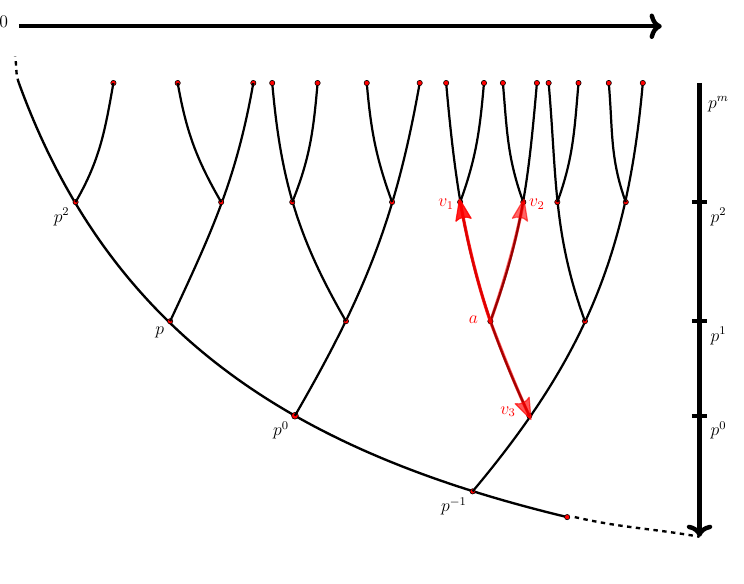
Figure 3 . A junction of three Wilson lines connecting its nearest